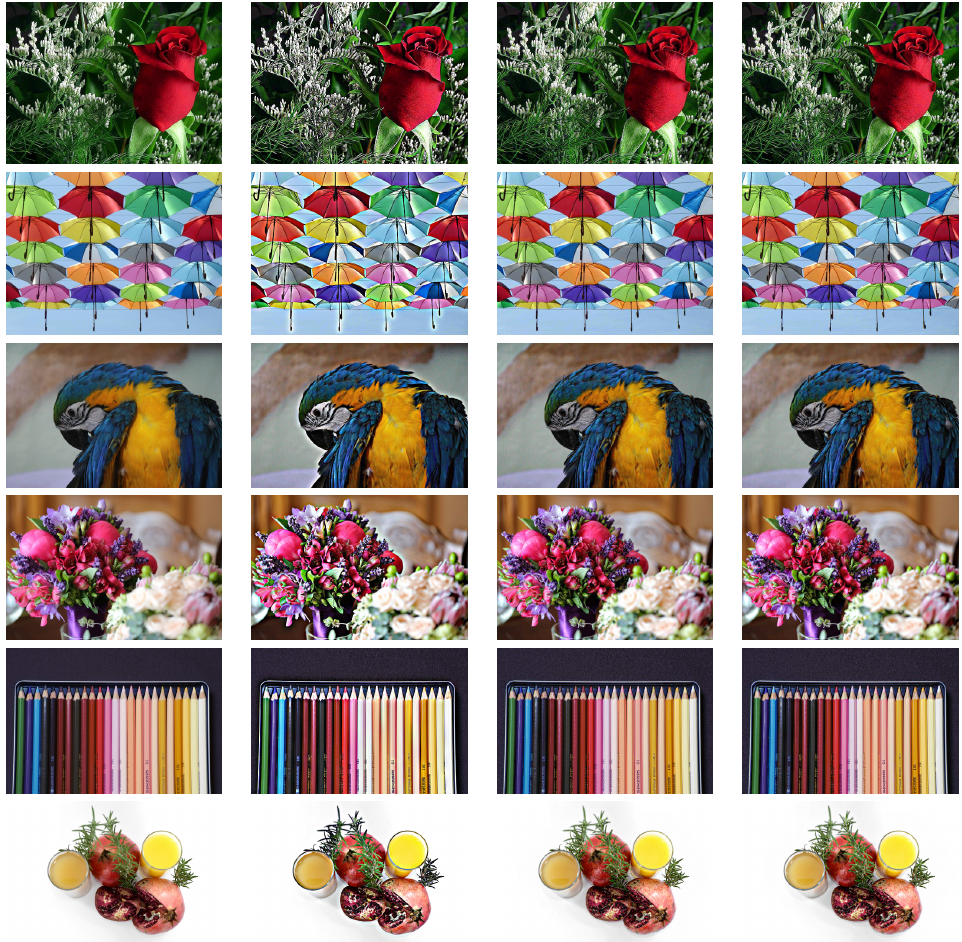
Figure 3. Example results for linear contrast enhancement with a = 2. Original images in the first column, Poisson solution in the second, ad hoc anisotropic diffusion with K = 10 − 3 in the third, and the proposed variational with K = 3 × 10 − 4 in the fourth. All images are available under the CC0